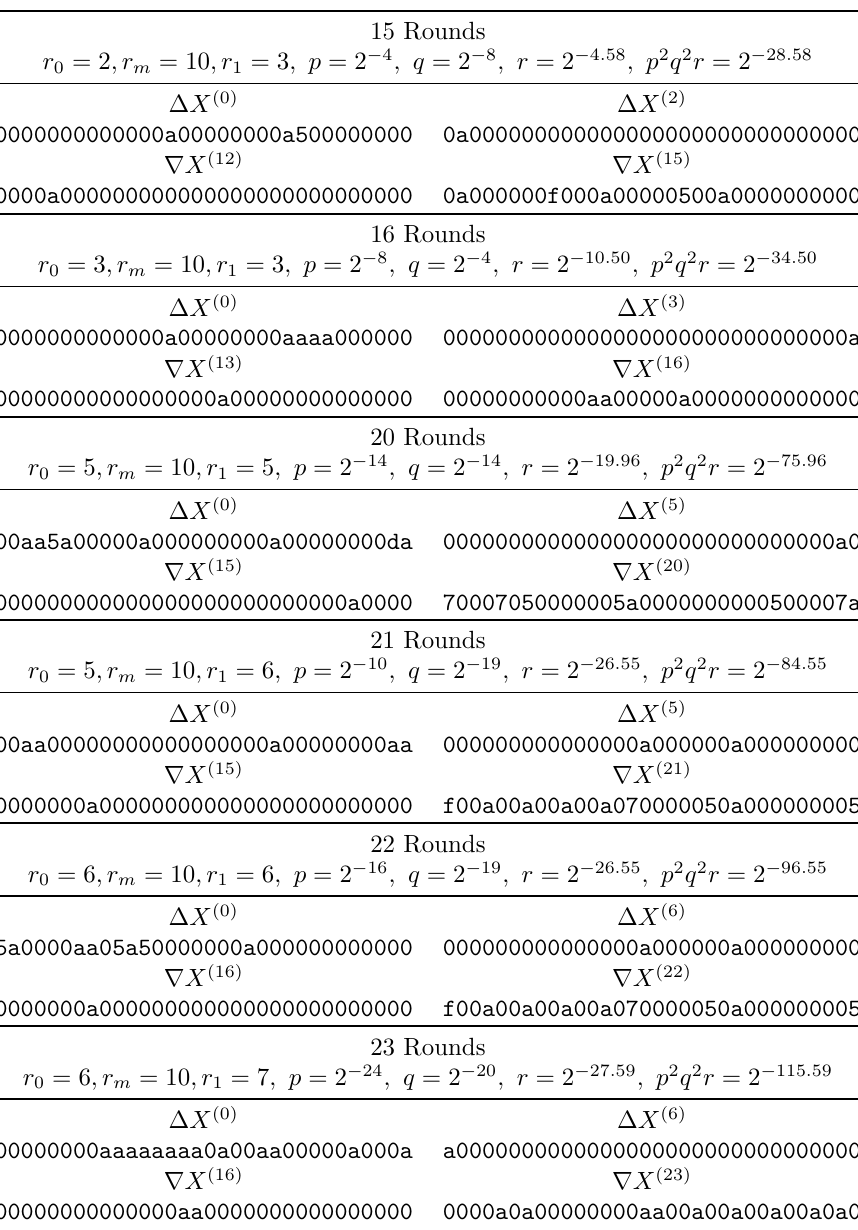
Table 10: Specification of Sandwich Distinguishers for WARP . 15